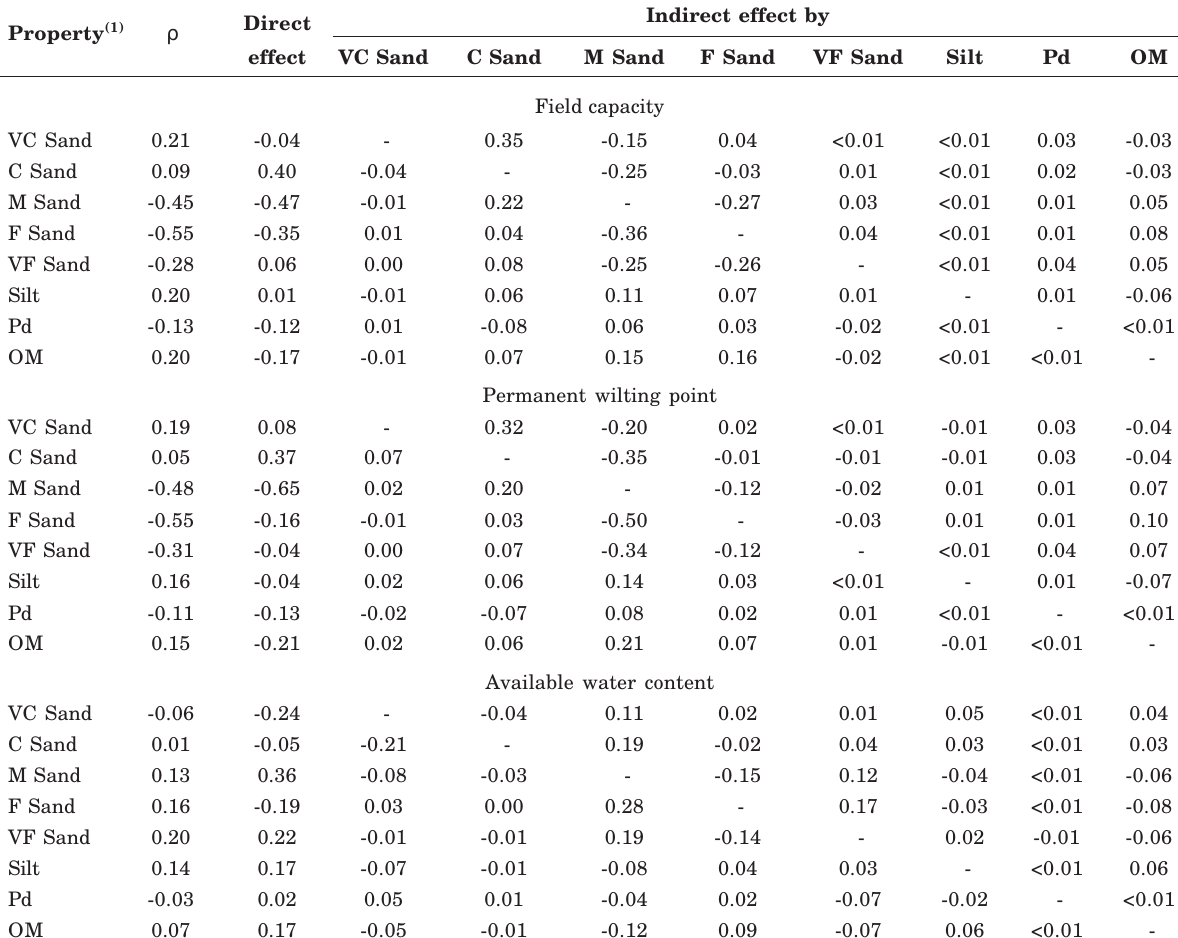
Table 5. Correlation coefficients considering the direct and indirect effects obtained through path analysis, between sand contents (five fractions), silt and particle density (Pd) and organic matter (OM), versus field capacity (10 kPa) and permanent wilting point (1,500 kPa), and available water content in subsurface horizons of different soil profiles in the state of Santa